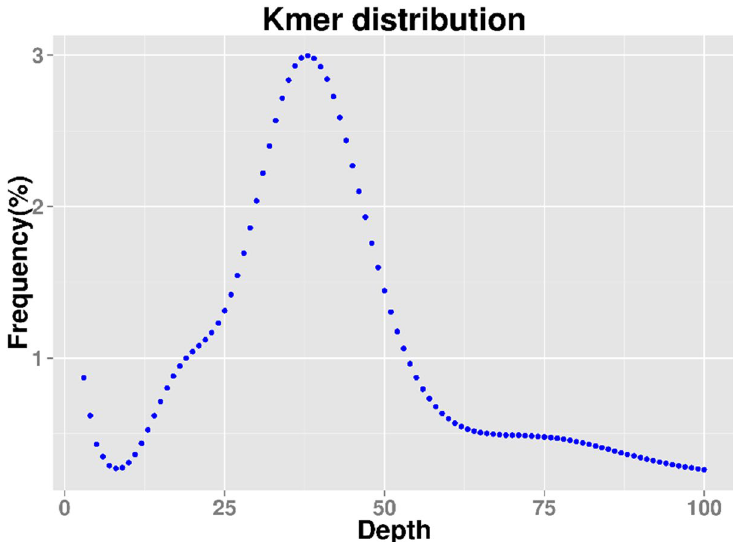
Figure 1. Estimation of P. palustre genome size using k-mer (k = 19)